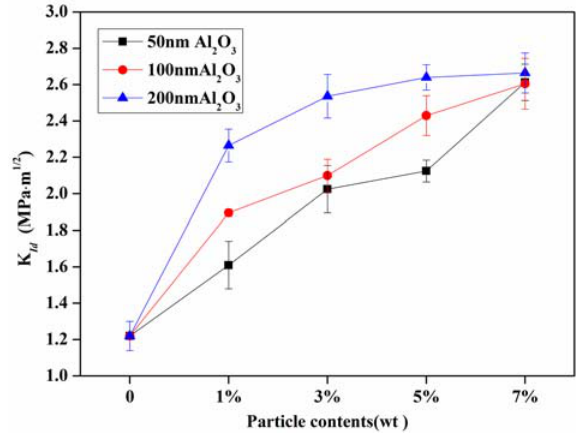
Figure12. Crack initiation toughness ( K Id ) of particle modified epoxy resin. Figure 12. Crack initiation toughness ( K